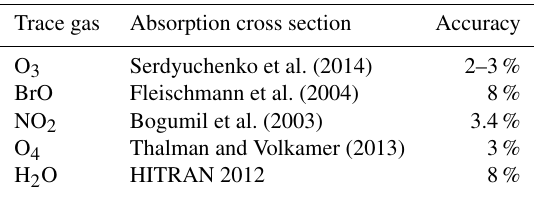
Table 3. Source of absorption cross sections and reported accura- cies. Trace